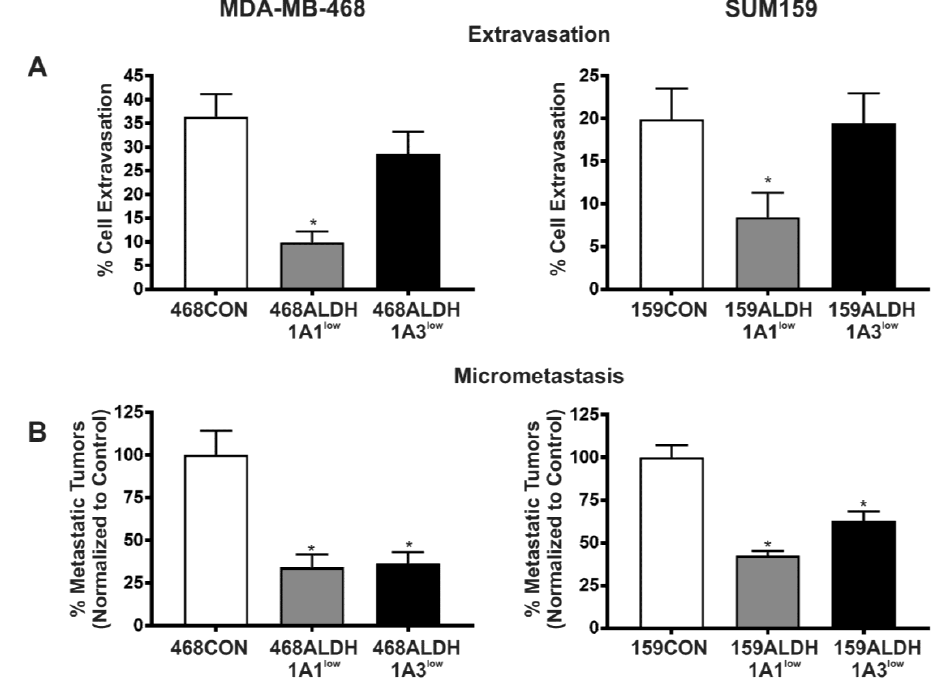
breast cancer cells in the chick CAM assay. GFP-labeled MDA-MB-468 or CMFDA-labeled SUM159 cell populations were transfected with 100pmol (MDA-MB-468) or 400pmol (SUM159) siRNA targeted towards ALDH1A1, ALDH1A3, or scrambled control using Lipofectamine to generate the following cell lines: 468CON, 468ALDH1A1 low , 468ALDH1A3 low , 159CON, 159ALDH1A1 low